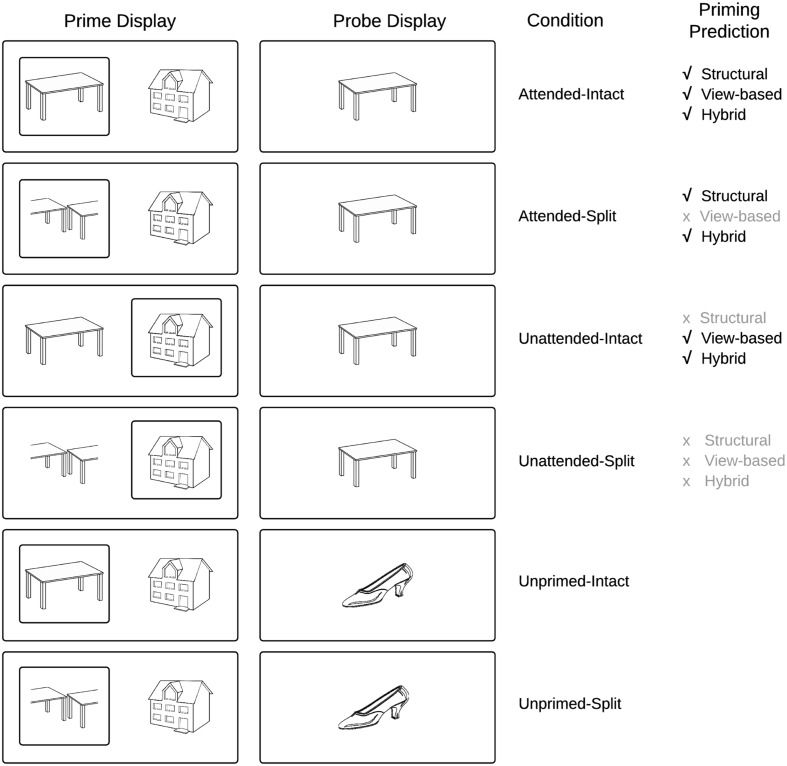
Schematic overview of experimental conditions and predictions derived from current models of object recognition.